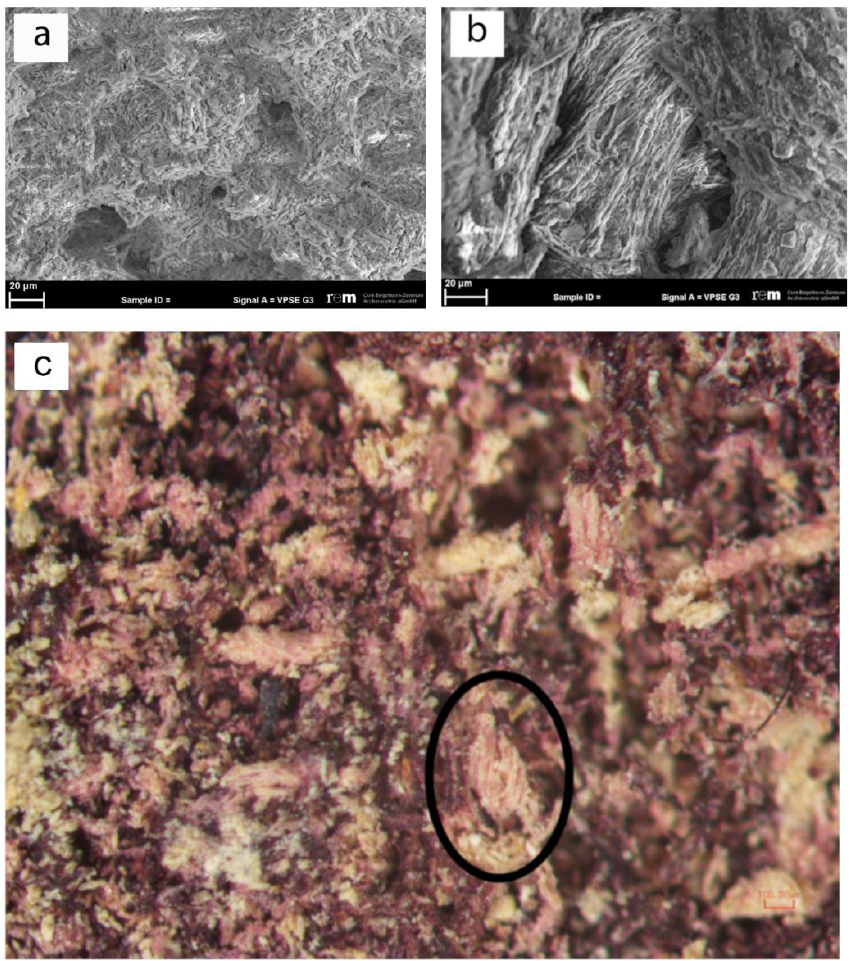
Figure 2. ( a ) SEM evidence of alteration of morphology of the sample’s fibers; ( b ) Presence of crystals with characteristic gypsum structures on altered fibers; ( c ) Stereo microscope image evidencing the z-twist feature (black